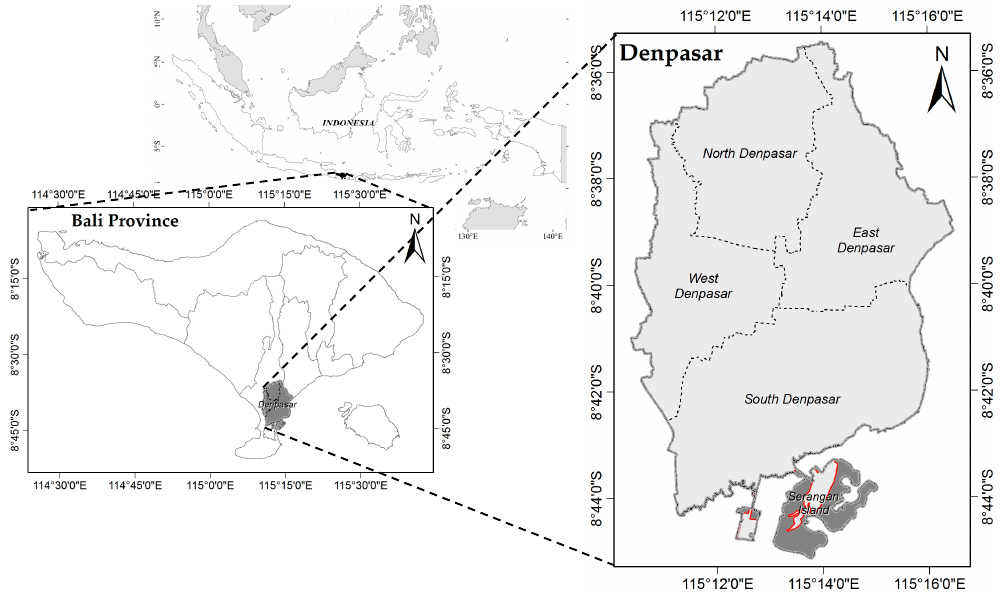
Figure 1. The research location: Denpasar, Bali Province, Indonesia. Dark grey regions in southern Denpasar are Serangan Island and Benoa port after reclamation, and these areas are used for Denpasar boundaries in 2003 and 2014. The dotted line inside Denpasar is the district boundaries.